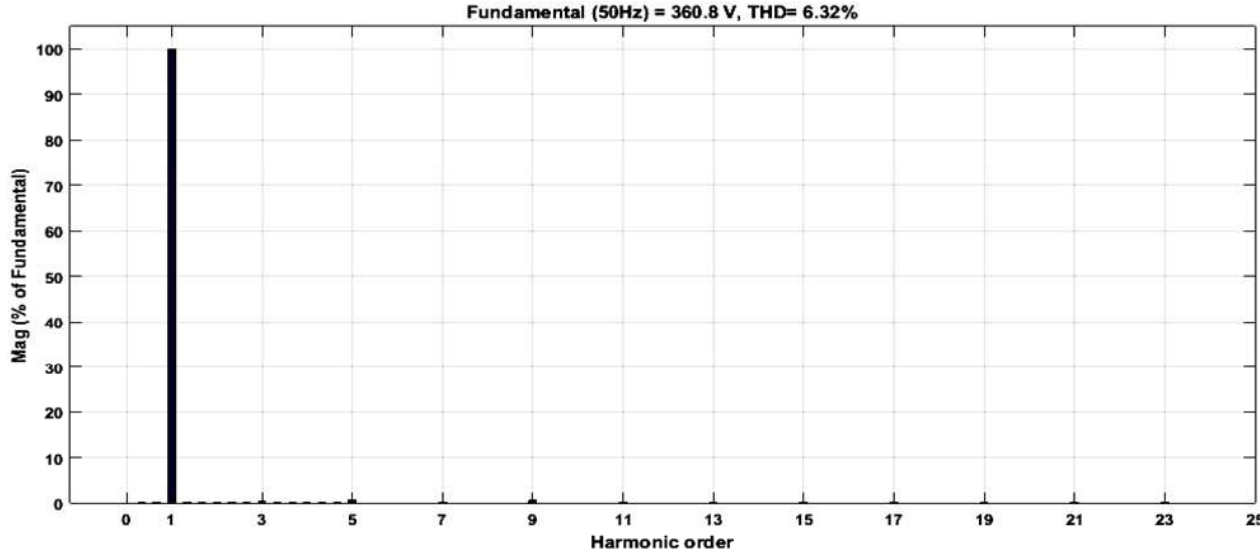
Figure 26. Percentage of THD for the 21-level multilevel inverter using the SPWM digital switching controller with a carrier frequency of 20 kHz.